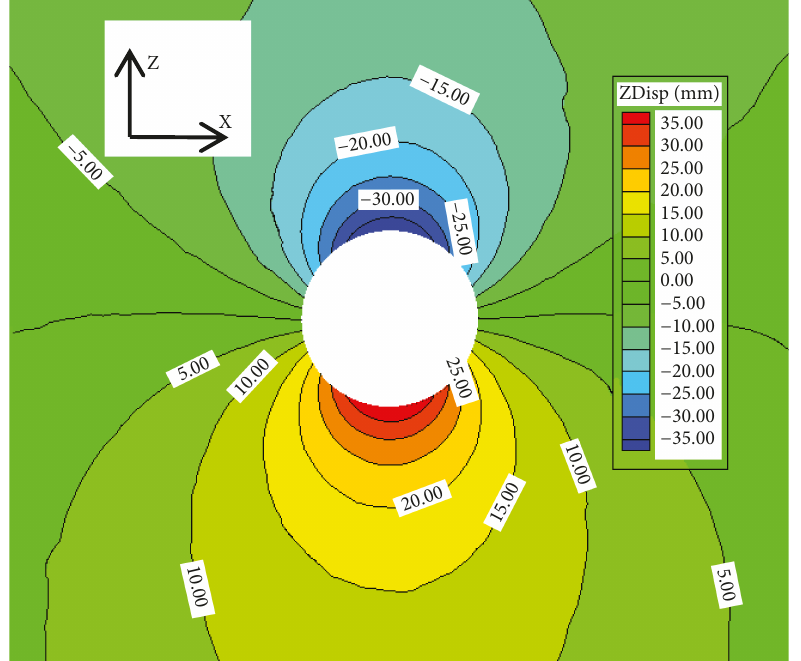
Figure 27: Displacement of section D-D along